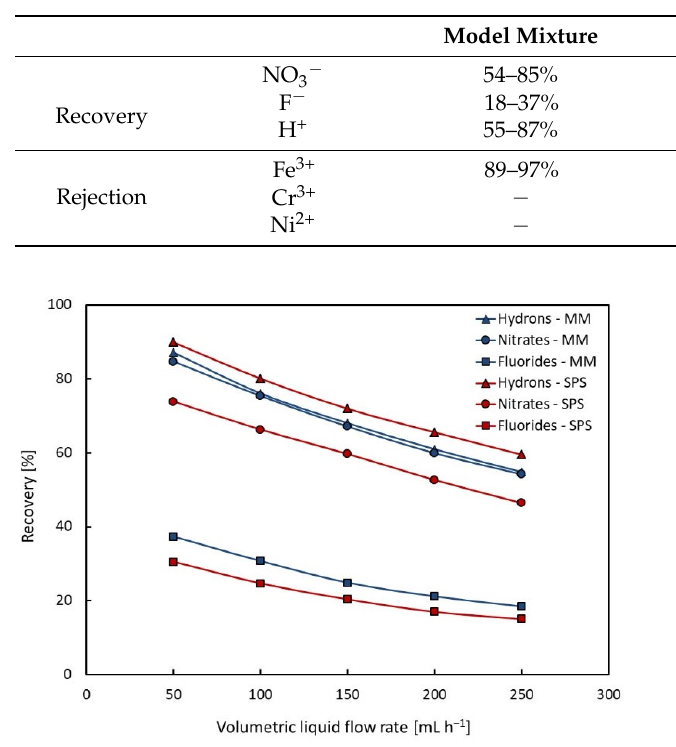
Table 3. Recovery and rejection (for volumetric liquid flow rate 50–250 mL h − 1 ).